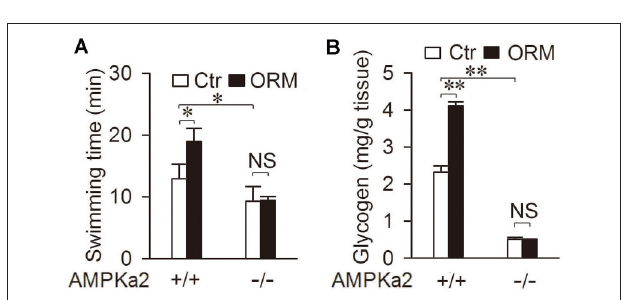
FIGURE 6 | AMPK mediates the anti-fatigue and glycogen-storage action of ORM. (A) Swimming time of AMPK α 2 + / + or AMPK α 2 − / − mice 30min after tail-vein injection with vehicle (Ctr) or 200mg/kg ORM. n = 6 per group. (B) Muscle glycogen content 30min after tail-vein injection with vehicle or 200mg/kg ORM in AMPK α 2 + / + or AMPK α 2 − / − mice. n = 6 per group. All data are expressed as the mean ± s.d. NS, non-significant, * P < 0.05, ** P < 0.01 by two-way ANOVA with Turkey’s post-hoc